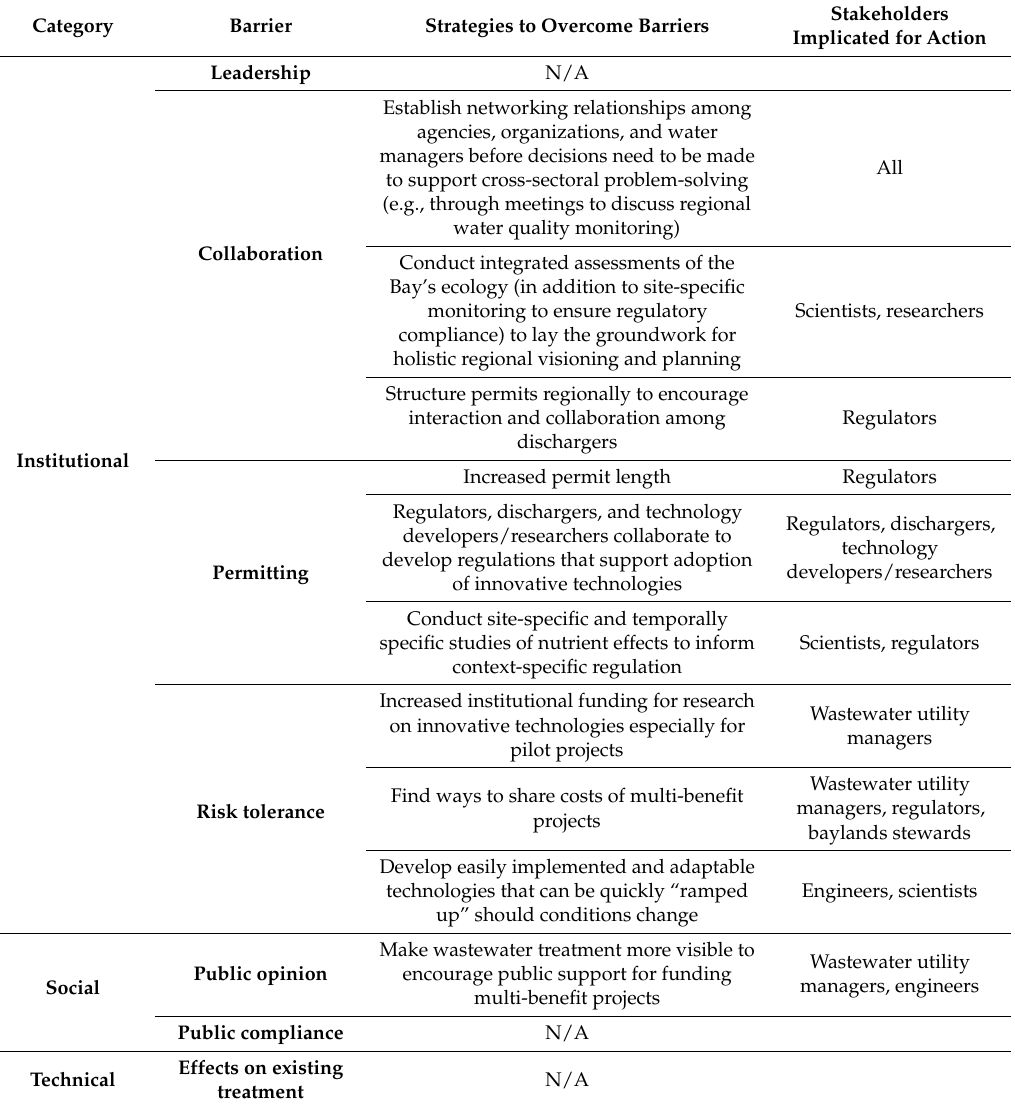
Table 4. Suggested strategies to overcome barriers to multi-benefit wastewater infrastructure in the San Francisco Bay Area. N/A: No interview responses addressed how to overcome this